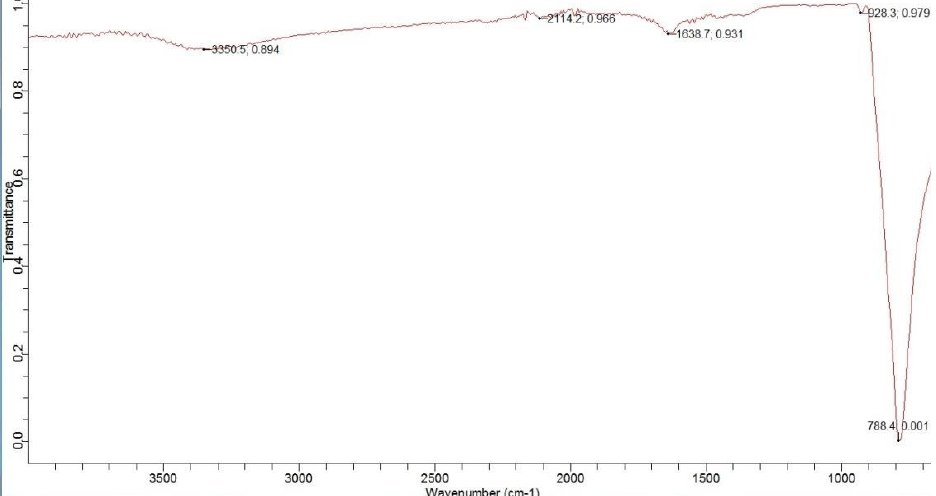
Figure 7. FTIR spectrum of C 3 N 4 -SrWO